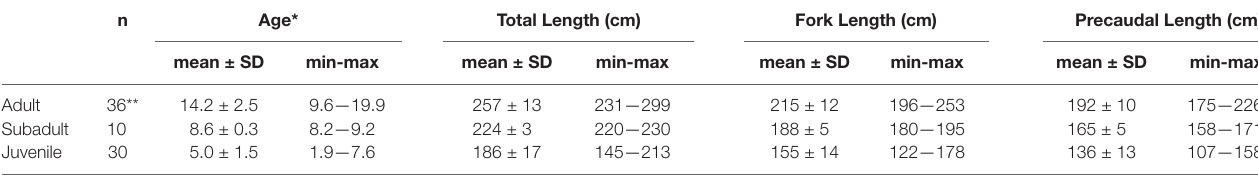
TABLE 3 | Age and size class for in situ sand tiger sharks Carcharias taurus .